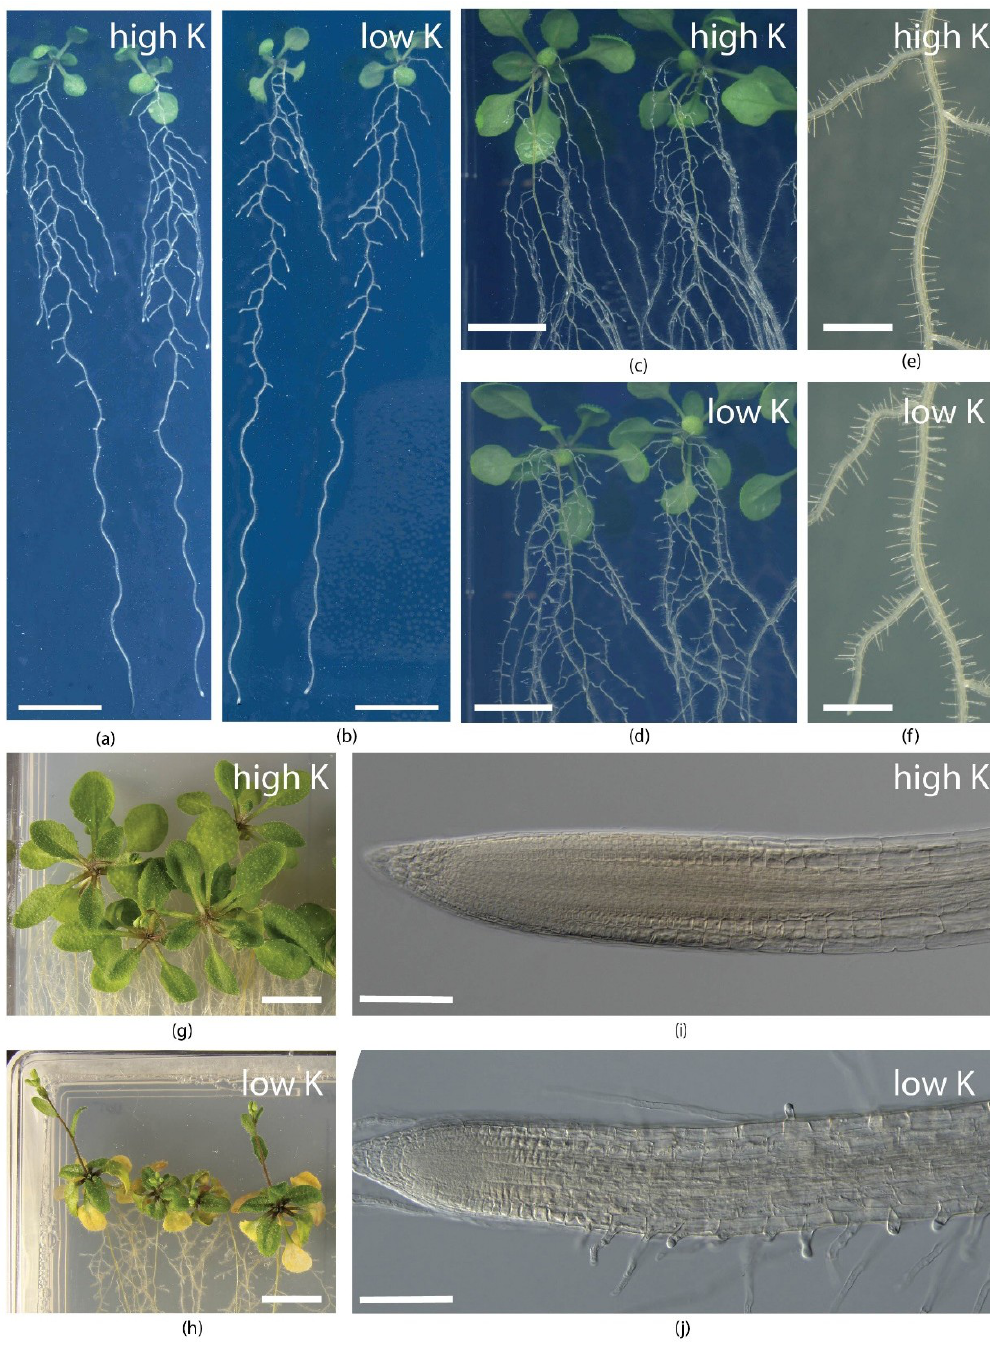
Figure 1. Symptoms of K + deprivation in Arabidopsis thaliana : Root systems of 10-day-old in vitro plants on ( a ) high-K and ( b ) low-K media show preferential inhibition of the first-order lateral root growth in low-K. Root system branching of 16-day-old in vitro plants on ( c ) high-K and ( d ) low-K media with enhanced branching to higher orders in low-K. Root hairs of in vitro plants on ( e ) high-K and ( f ) low-K media. Shoots of 16-day-old in vitro plants on ( g ) high-K and ( h ) low-K media with symptoms of K + deficiency on leaves in low-K. Lateral root apex of ( i ) high-K and ( j ) low-K plants. High-K medium: 0.2x strength MS (Murashige and Skoog) with 4 mM K + ; low-K medium: 0.2x strength MS with 15 µ M K + . Media were supplemented with 1% agar and 1% sucrose. Scale bars: 1 cm ( a – d , g – h ); 2 mm ( e – f ); 100 µ m ( i – j